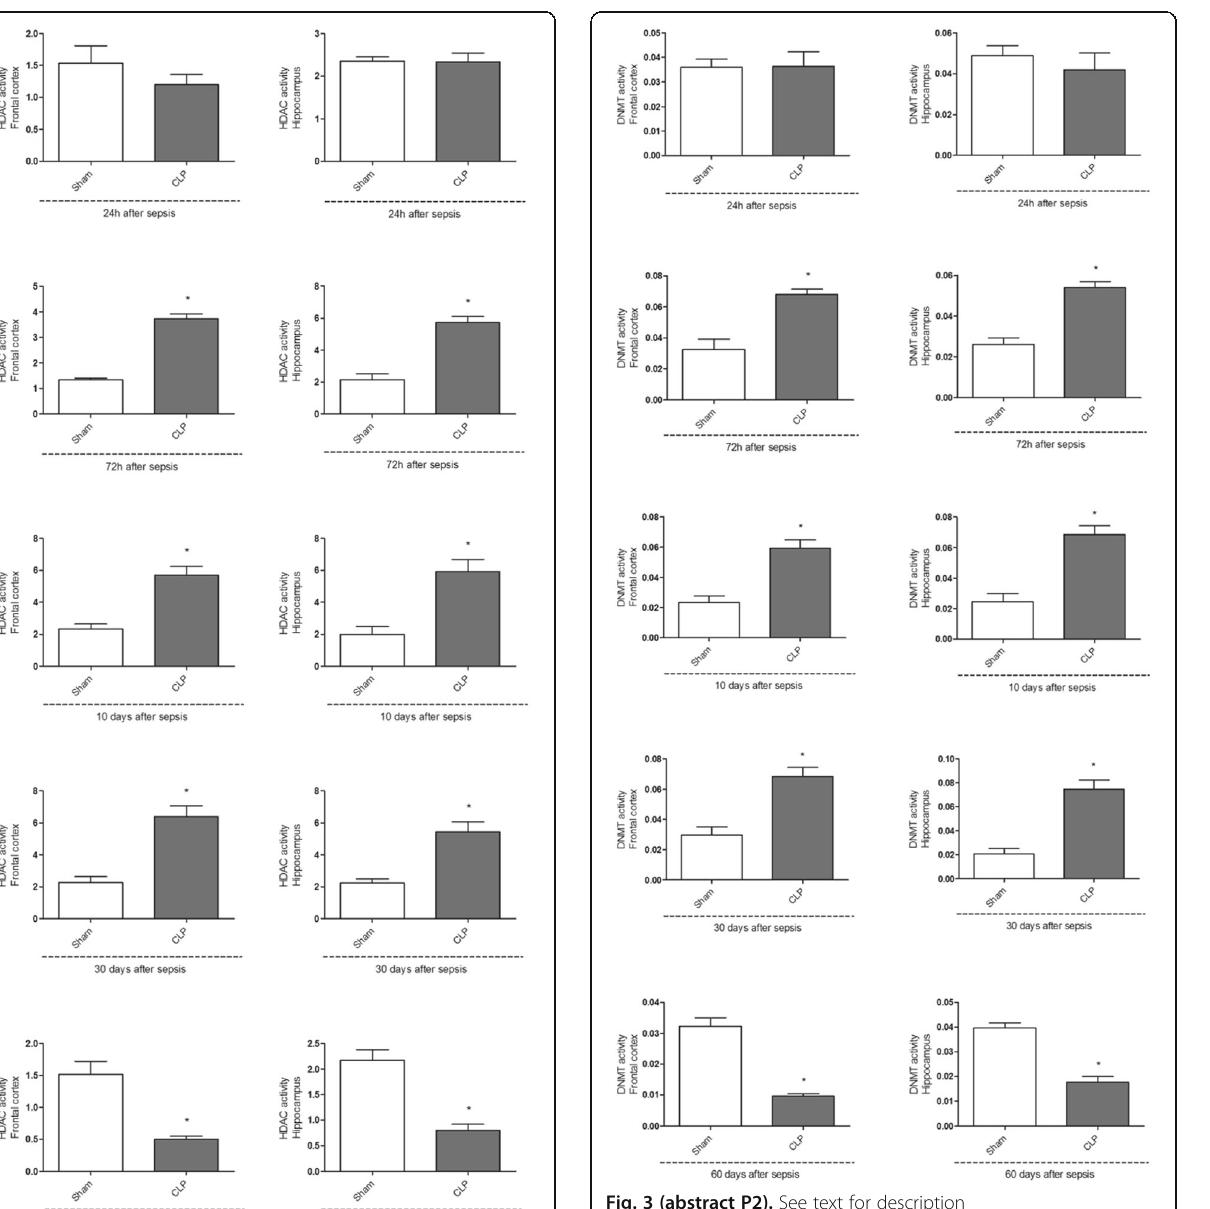
Fig. 3 (abstract P2). See text for